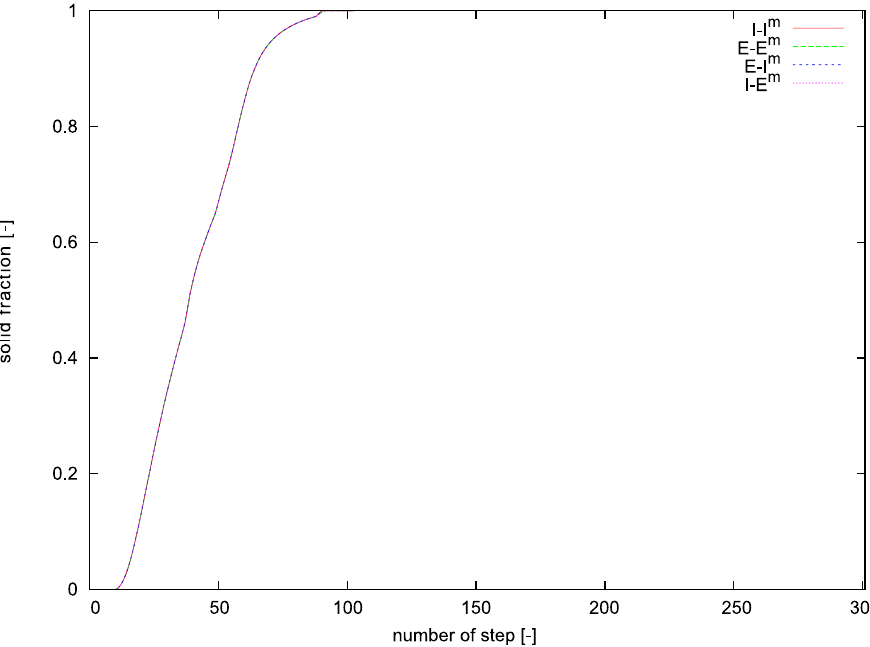
Figure 11. Solid phase growth obtained for selected point in casting domain. Solid phase fraction for multiplication factor m = 15 calculated by mixed time partitioning